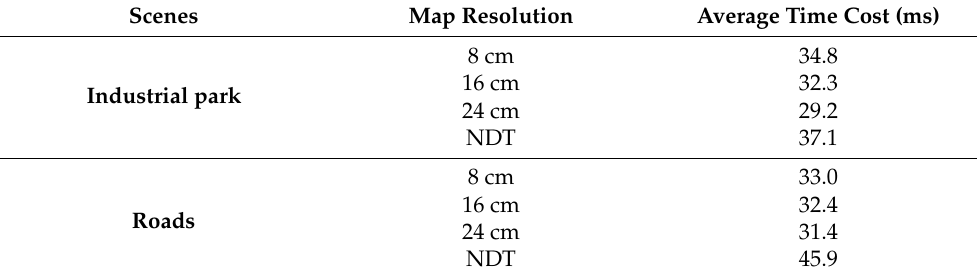
Table 7. Average time cost of scan-to-map matching in industrial parks and